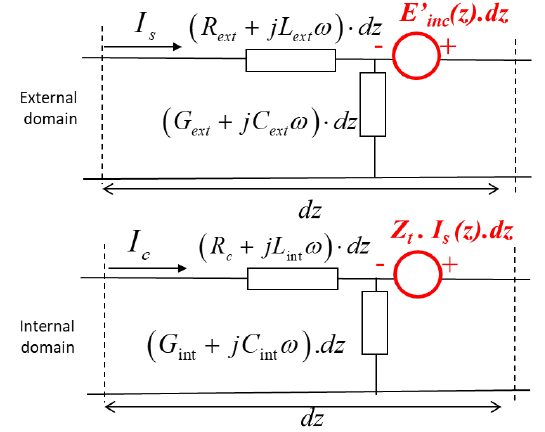
FIGURE 11. The two-step approach TL circuit cell model. Above, TL-cell for the calculation of the shield current I s . Below, TL-cell for the calculation of the core current I c .